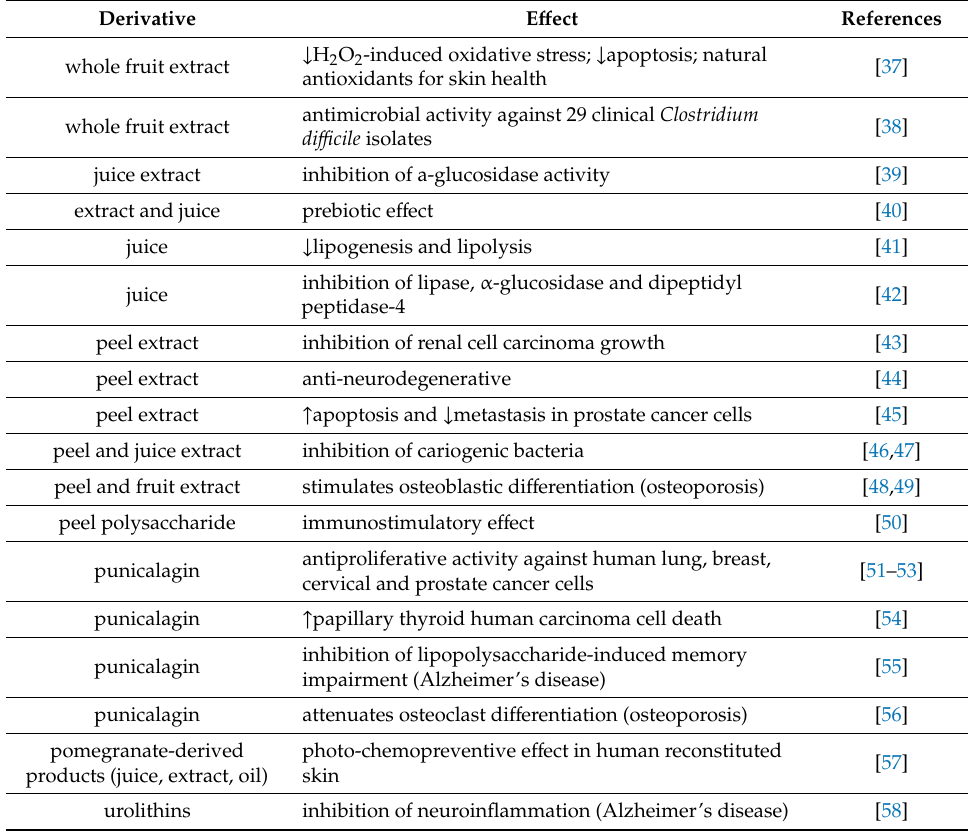
Table 3. Recent health-related pomegranate in vitro